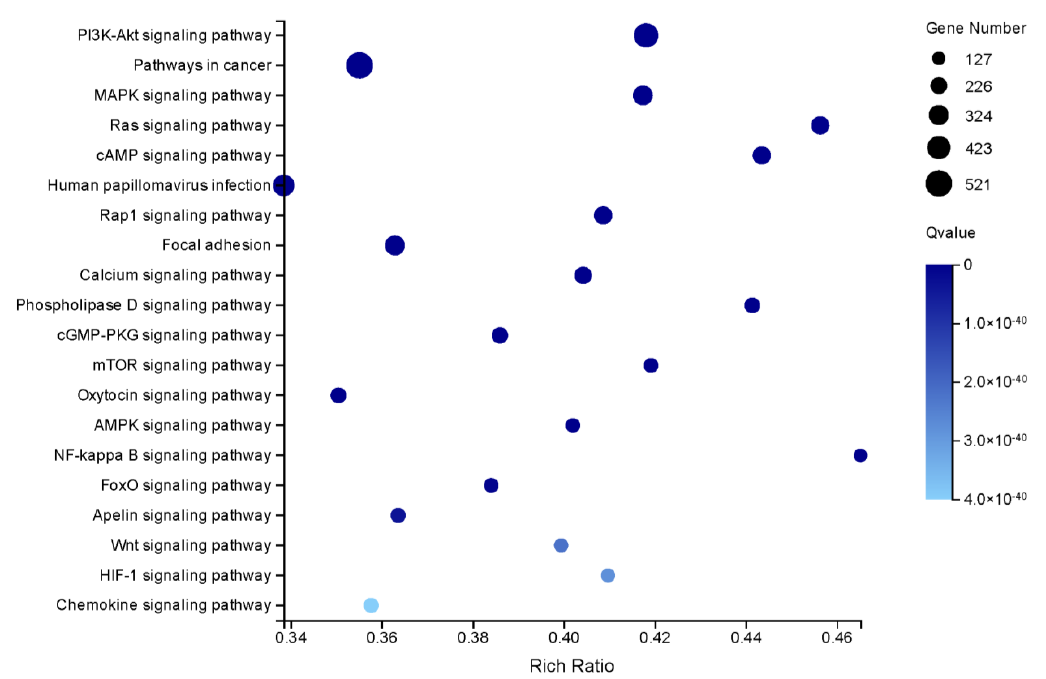
Figure 5. KEGG pathway enrichment analyses of the DEGs.